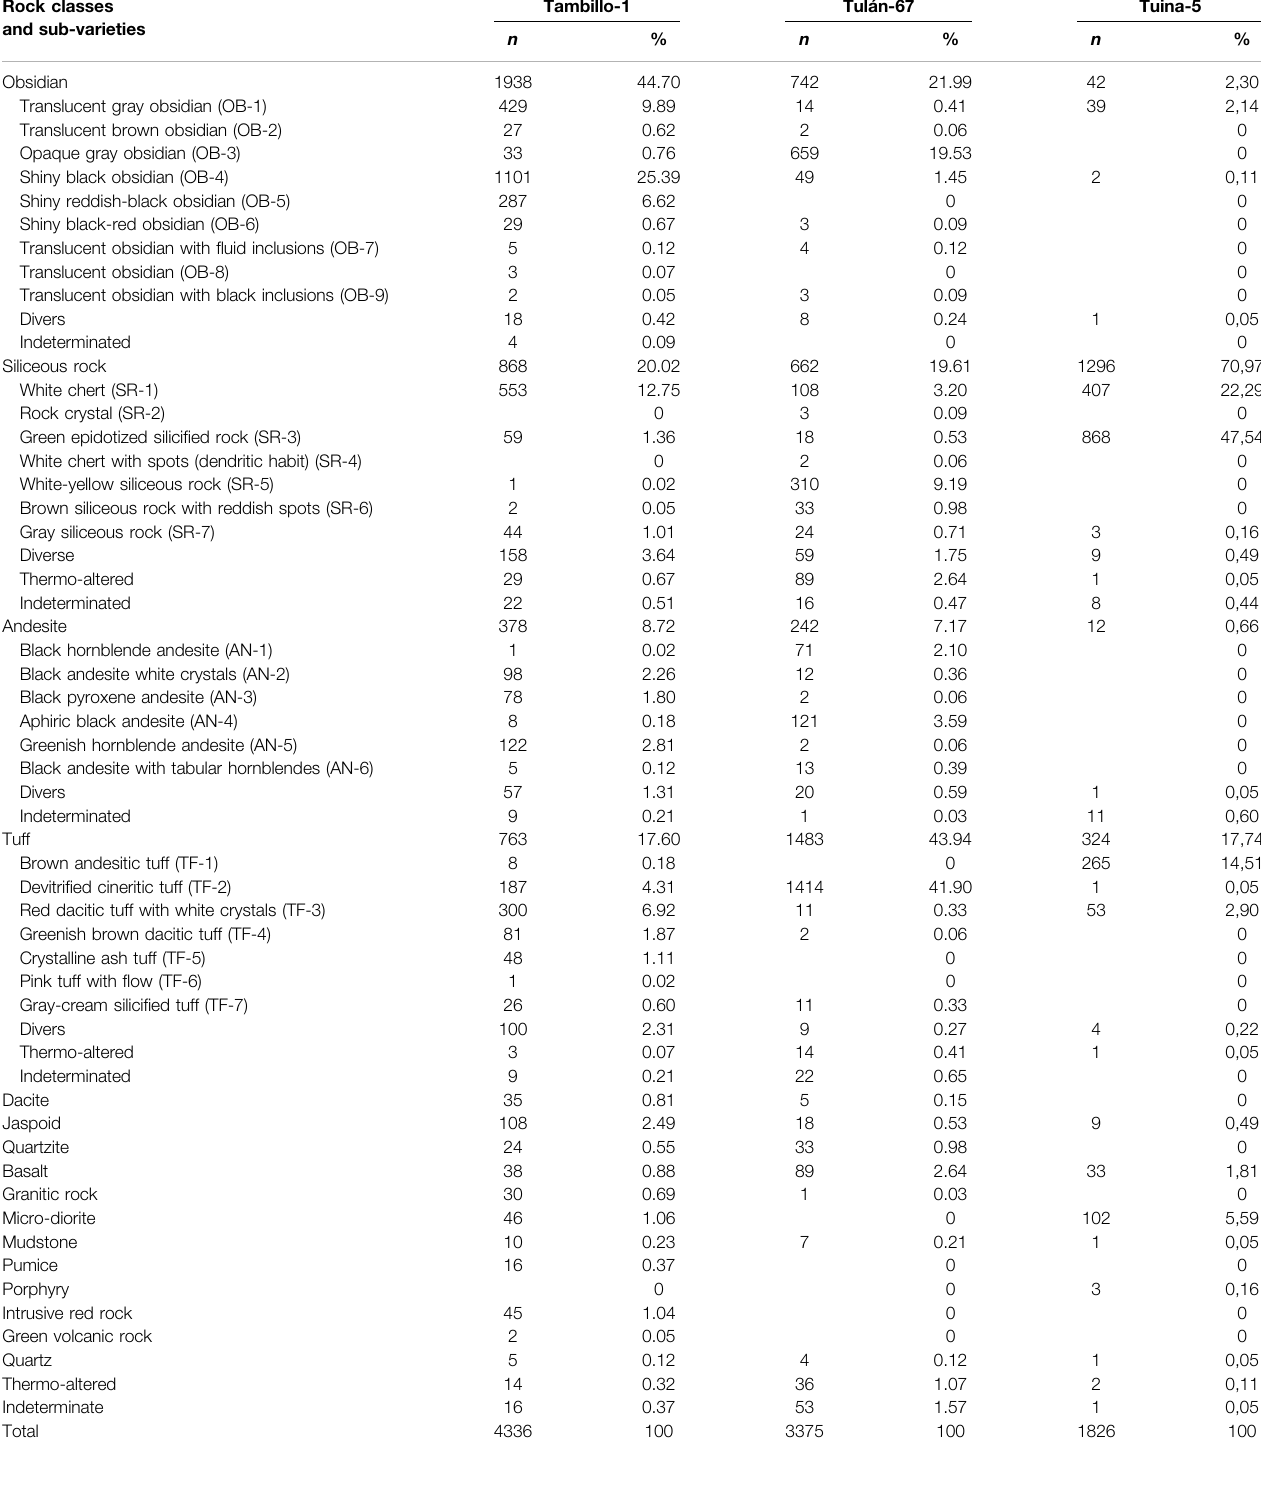
TABLE 2 | General rock classes and sub-varieties by archaeological site. Rock classes and sub-varieties